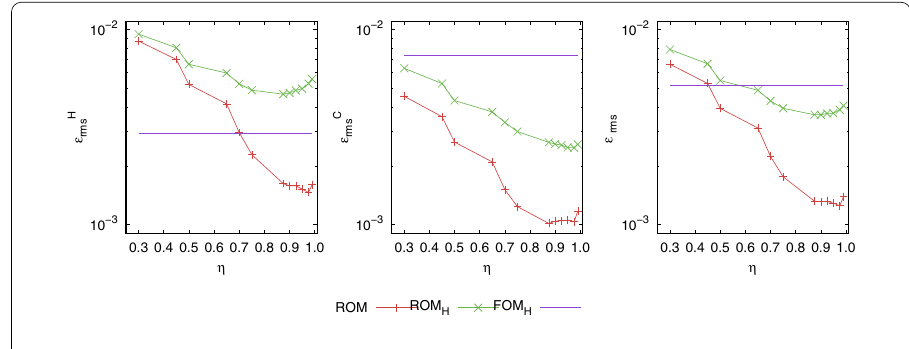
Fig. 7 (cid:14) rms convergence. Hot wall (cid:14) H rms , cold wall (cid:14) C rms , and mean ¯ (cid:14)